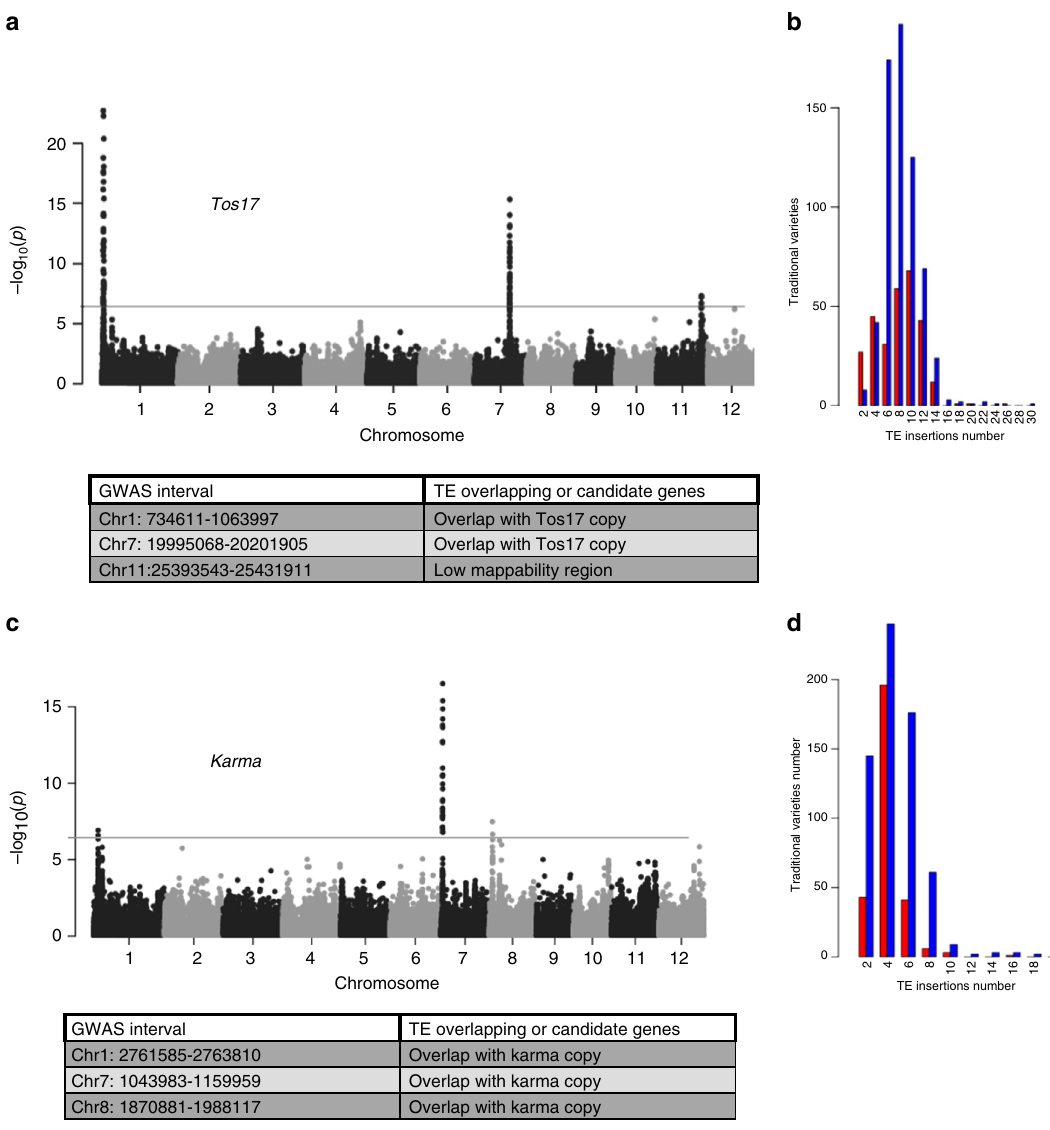
Fig. 4 GWAS analysis of Tos17 and Karma TE families. GWAS analysis for Tos17 ( a ) and Karma ( b ) TE families. Manhattan plot represents the log10 p value for each association between the single-nucleotide polymorhisms and the TE insertion (see Methods). TE insertion-SNP association p value >6 are signi fi cative. c , d The TE insertion distribution in rice traditional varieties (Fig. 3) re fl ects a polymorphism in TE copy number along rice varieties,